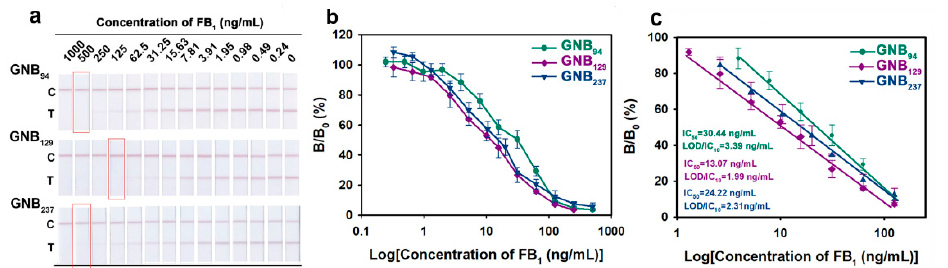
Figure 2. Effect of the GNB size on the detection sensitivity of competitive LFIA. ( a ) The prototypes of three GNB-LFIA strips responding to varying FB 1 concentrations. ( b ) The relationship analyses for three GNB-LFIAs between the B/B 0 × 100% value and the FB 1 concentration ranged from 0 to 1000 ng/mL. ( c ) The linear dependence of three GNB-LFIA strips obtained by plotting the B/B 0 × 100% against the logarithmic FB 1 concentration.